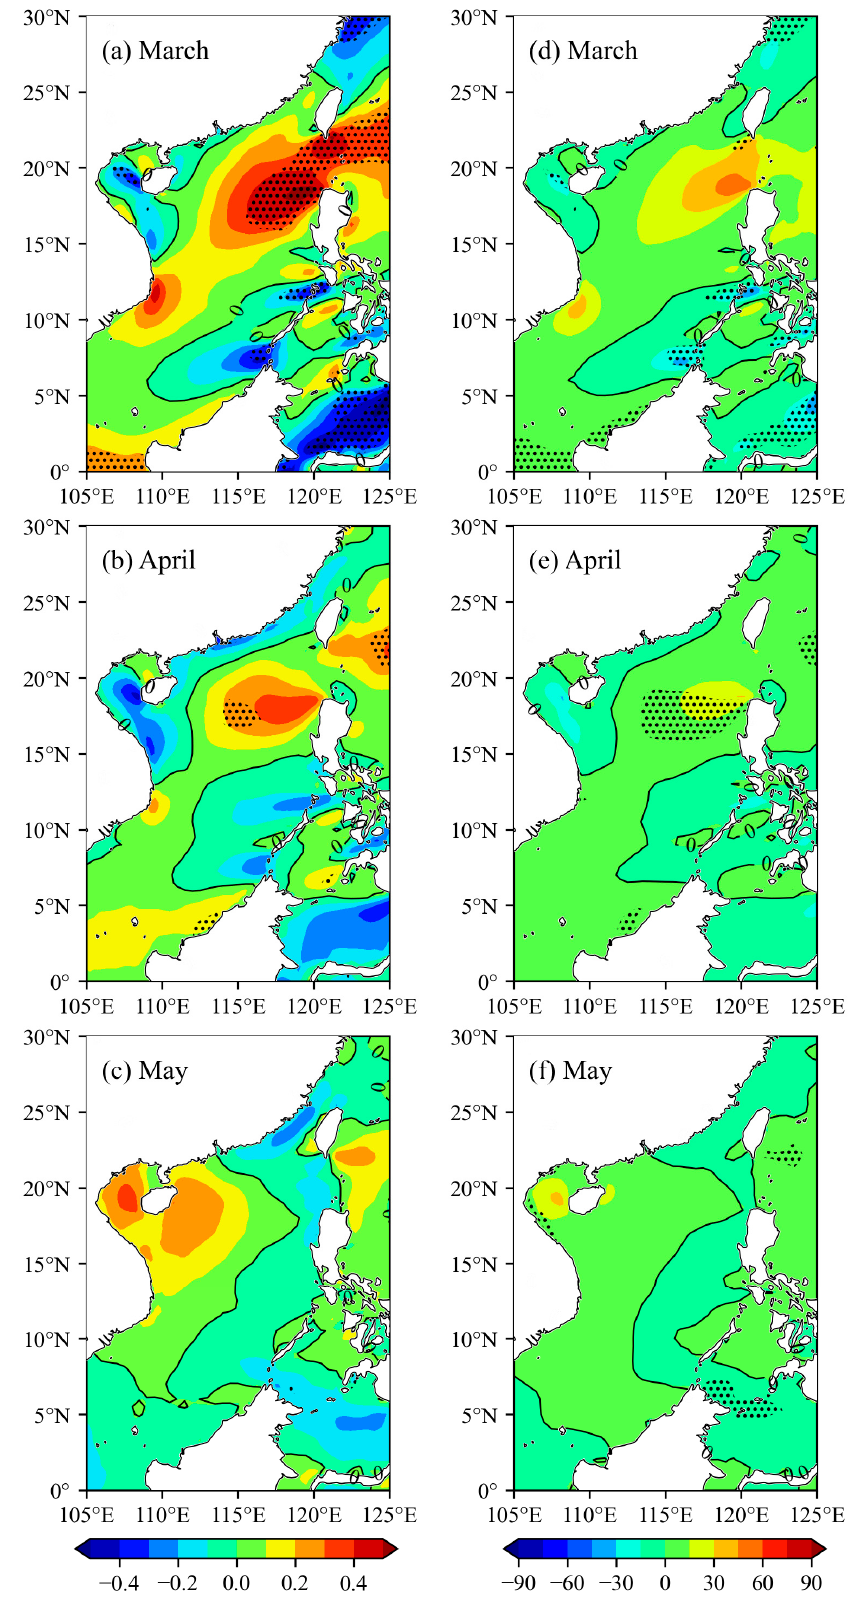
Figure 8. As in Figure 7, but for March ( a , d ), April ( b , e ), and May ( c , f ).